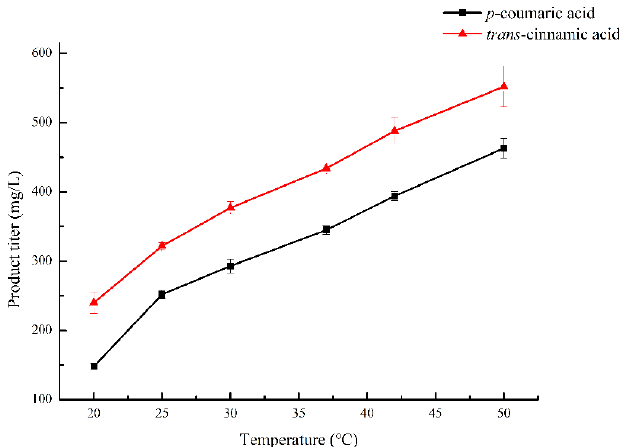
Figure 3. Effect of temperature on conversion of L-Phe and L-Tyr to trans -cinnamic acid and p -coumaric acid by E. coli BL21(DE3)/pETDuet-1- RgPAL . Reaction conditions: Time: 24 h; Medium: pH 9.0 10 mM Glycine-NaOH; L-Phe and L-Tyr 1 mg/mL; Cell amounts: 6.67 g/L.